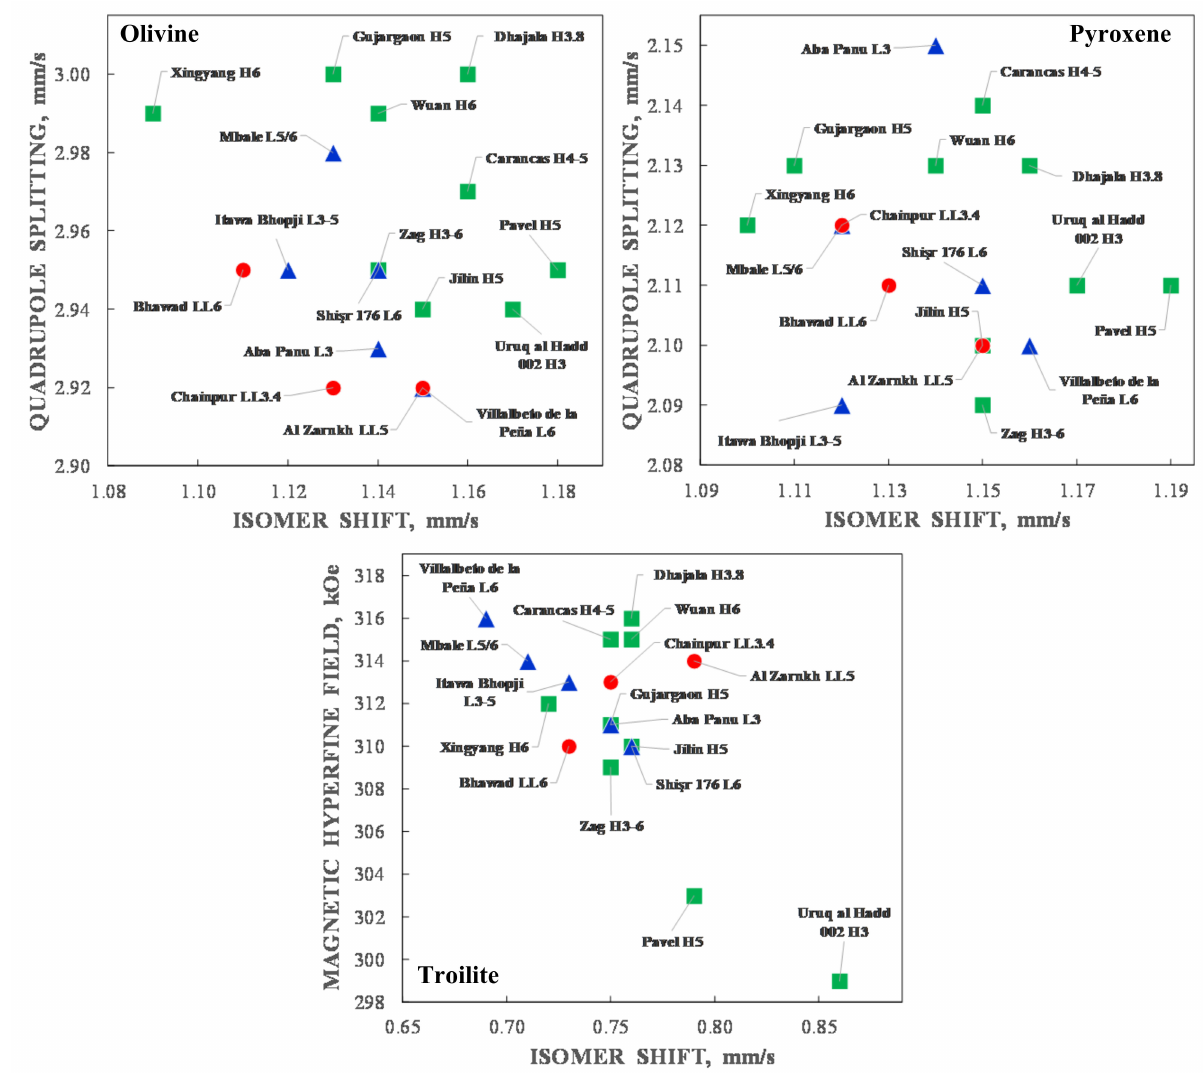
Figure 40. Comparison of the 57 Fe hyperfine parameters for olivine, pyroxene and troilite in selected ordinary chondrites from the H, L, and LL groups obtained by Mössbauer spectroscopy with a low velocity resolution. —H ordinary chondrites, —L ordinary chondrites, —LL ordinary chondrites. Data were taken for indicated meteorites in the